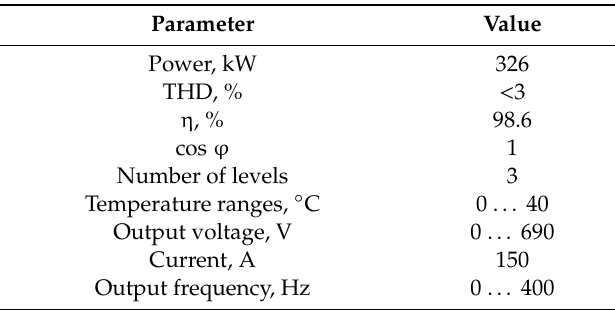
Table 2. Semiconductor converter data.